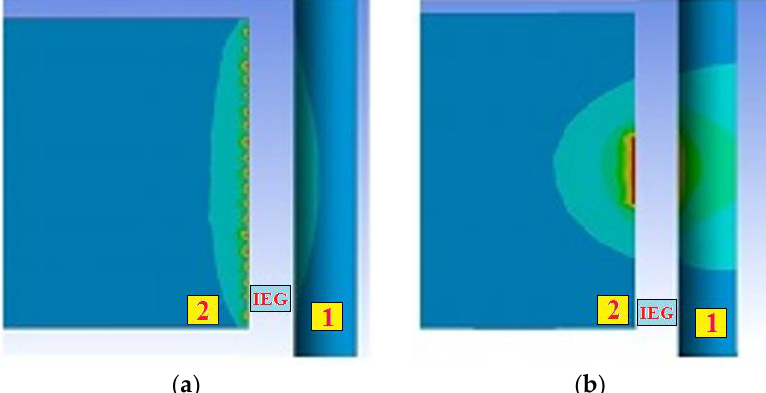
Figure 19. Examples of calculating temperature fields by the finite element method during the normal course of the EDM ( a ) and during the localization of discharges ( b ), where ( 1 ) is the tool electrode; ( 2 ) is the workpiece electrode.